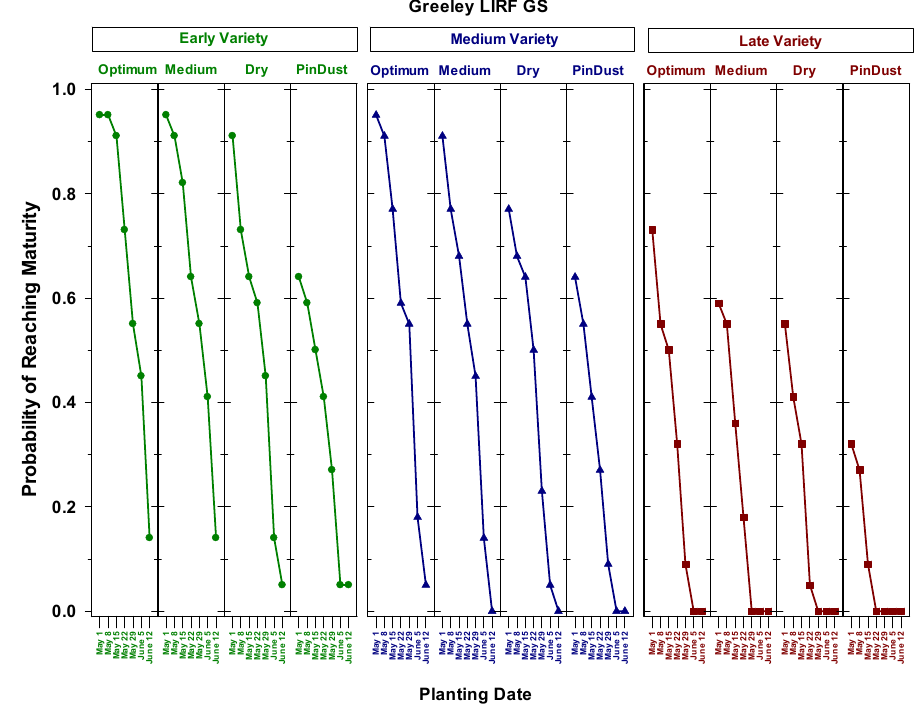
Figure 9. Probability of sorghum reaching physiological maturity at Greeley LIRF, Colorado, for seven planting dates using non ‐ stressed (GS) phenological parameters, three maturity classes, and four seedbed water conditions at planting.